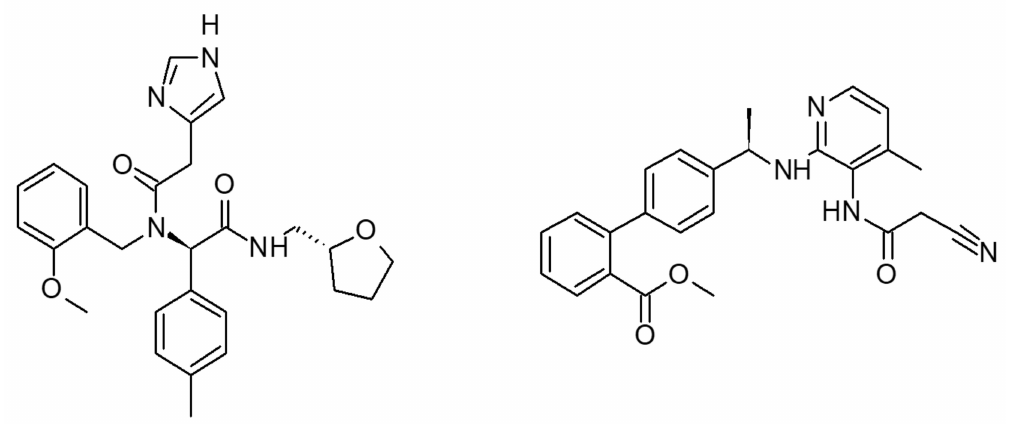
Figure 1. Chemical structures of DFL20656 (on the left) and Merck compound 14 (on the right). Docking results confirmed that the two compounds share the same region of the binding site, highlighting the importance of specific anchor points that were previously reported to be necessary for allosteric inhibition by our group [19] and specifically reported for B1 receptor inhibition in a recent paper [23]. Docking simulation highlighted how the compound DFL20656 interacts with N114 3.29 and W93 2.60 (Figure 2).